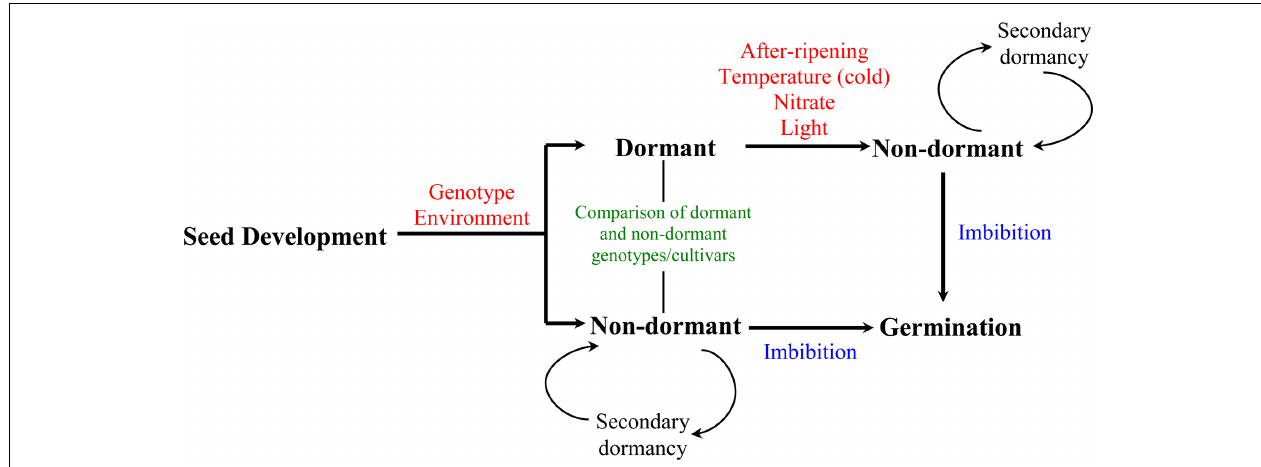
down. Non-dormant seeds complete germination once imbibed or may enter secondary dormancy if the environmental conditions are unfavorable for germination.The pathway for preharvest sprouting is represented by the seeds that go directly from development-maturation to non-dormancy to germination. Seed dormancy studies in wheat mainly involve after-ripening and comparative analysis of seeds from dormant and non-dormant